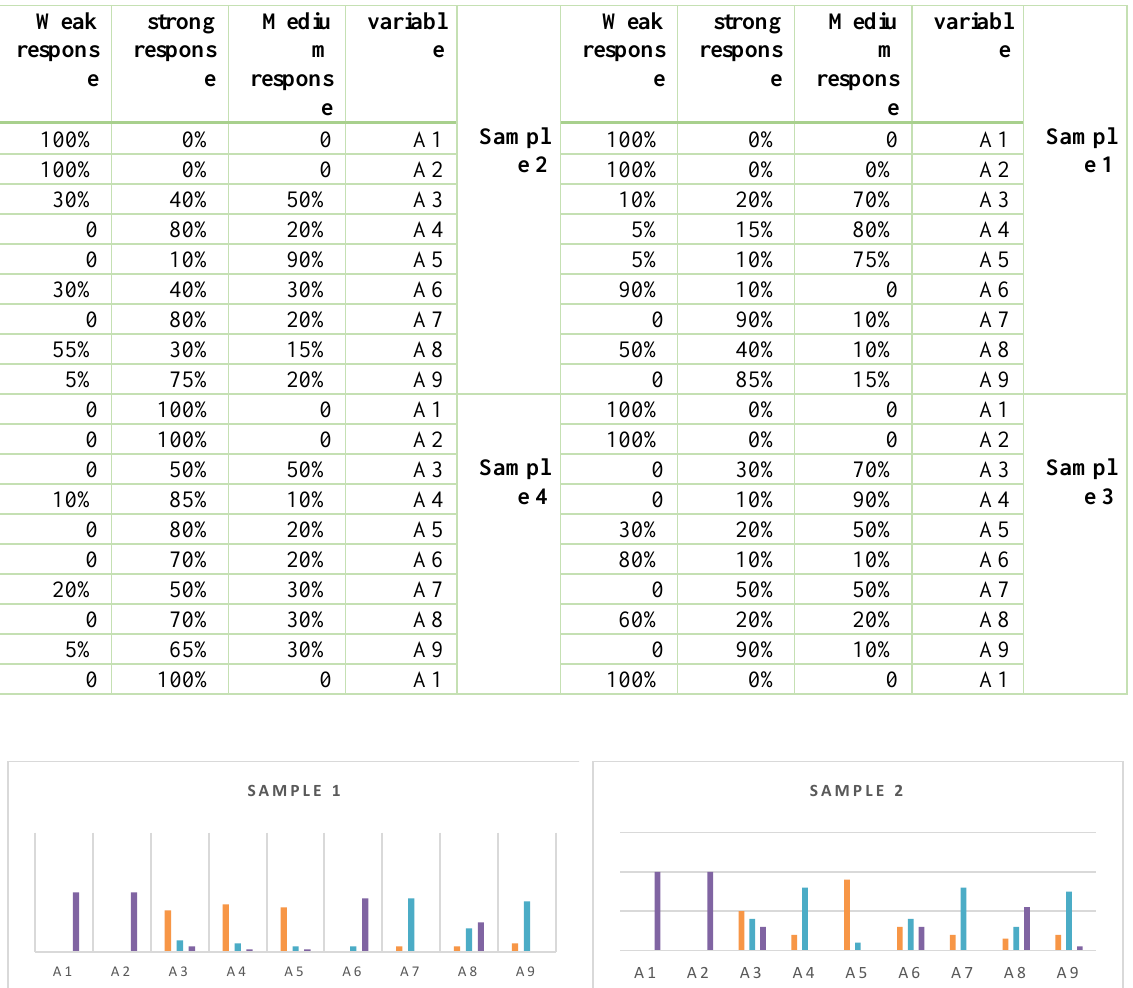
Fig. 9. The proportions of the questionnaire for sample 1.